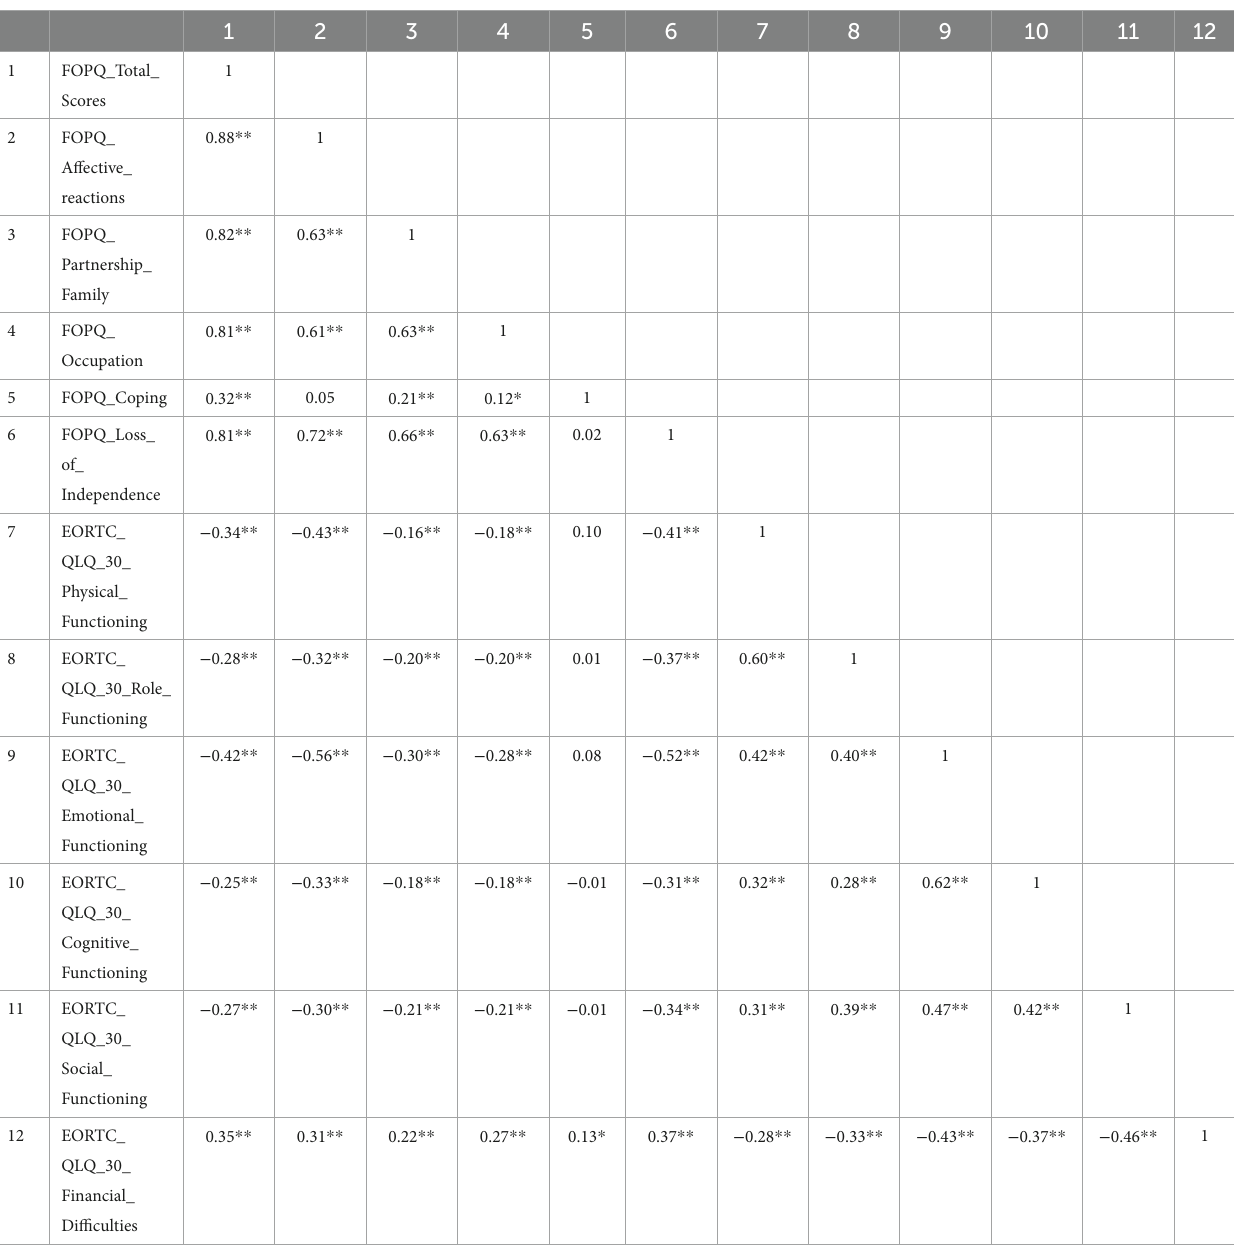
TABLE 3 Zero-order correlations for all study